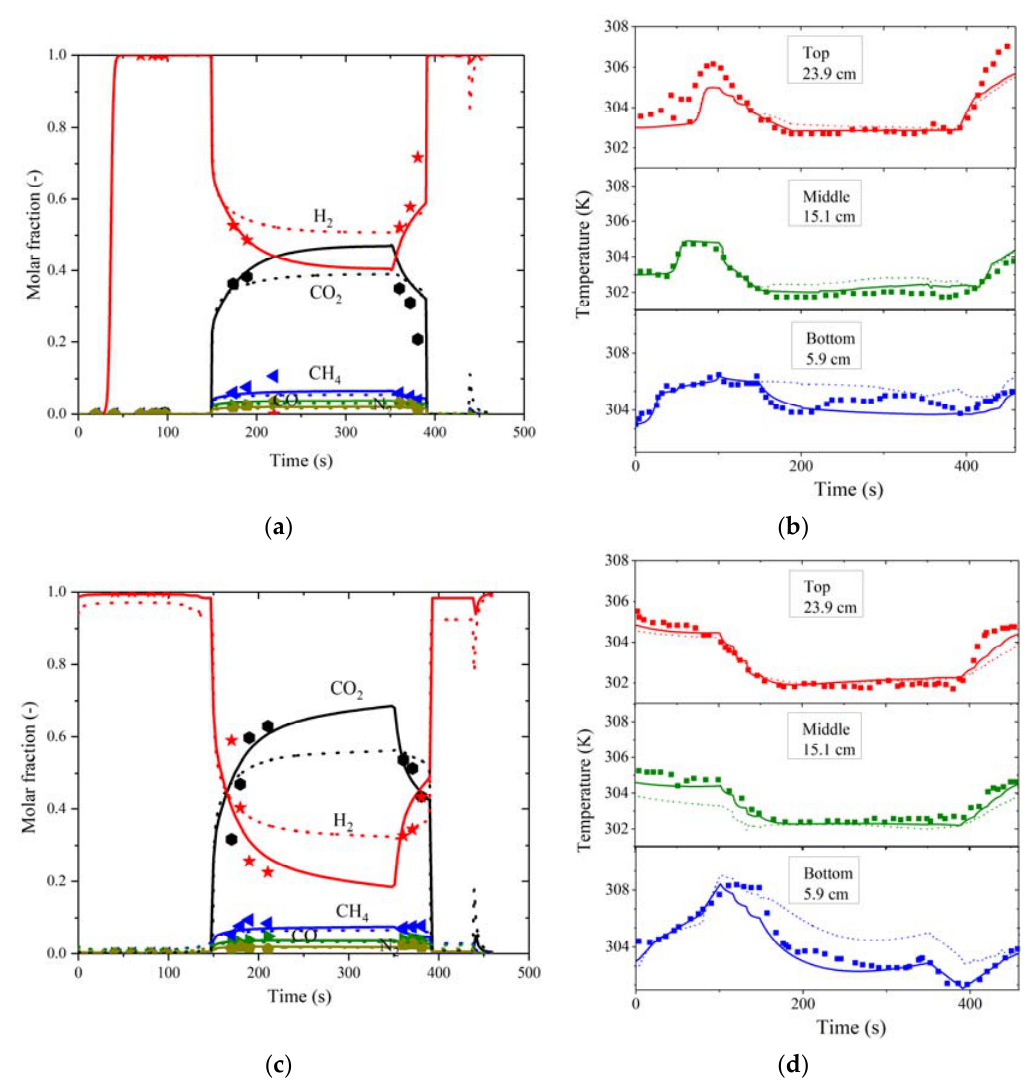
Figure 4. Changes in molar fraction and temperature for VPSA and PSA cycles in adsorption bed: ( a ) Molar fraction for cycle 1; ( b ) temperature profiles for cycle 1; ( c ) molar fraction for cycle 37; ( d ) temperature profiles for cycle 37. Symbols: Experimental data for VPSA from [35]. Lines: Simulation results of VPSA (—) and PSA (- - -).